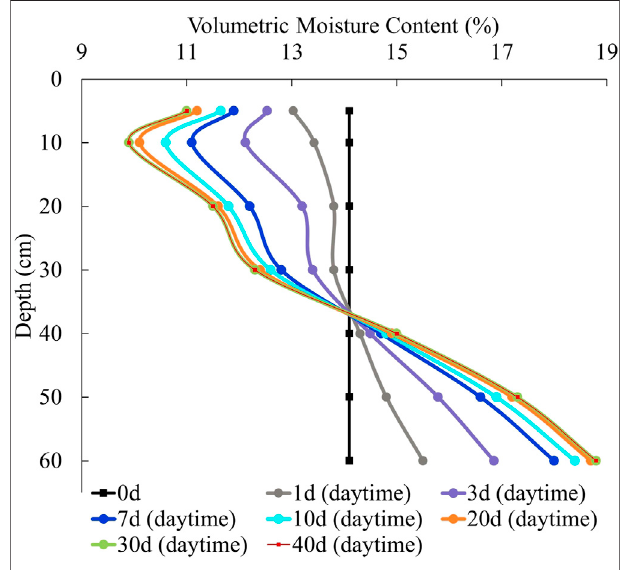
FIGURE 14 | Moisture distribution of the soil column along the depth.